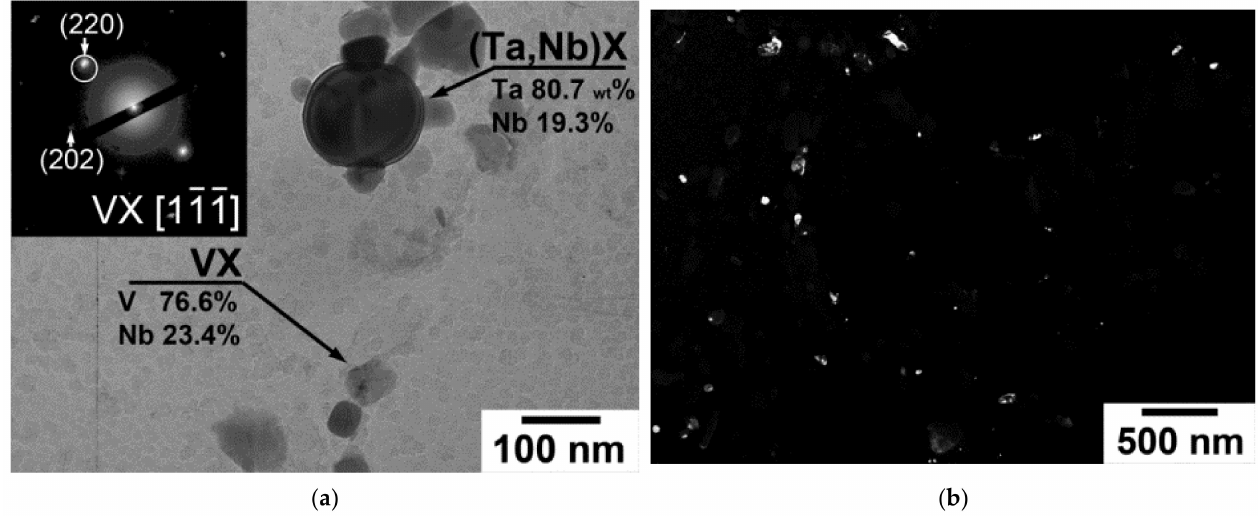
Figure 9. ( a ) Bright-field TEM image of the secondary-phase particles in the present 12% Cr steel after the TMP (on carbon replica) together with the electron diffraction pattern from V-rich MX particle and ( b ) dark-field TEM image in reflection (220) of VX phase.